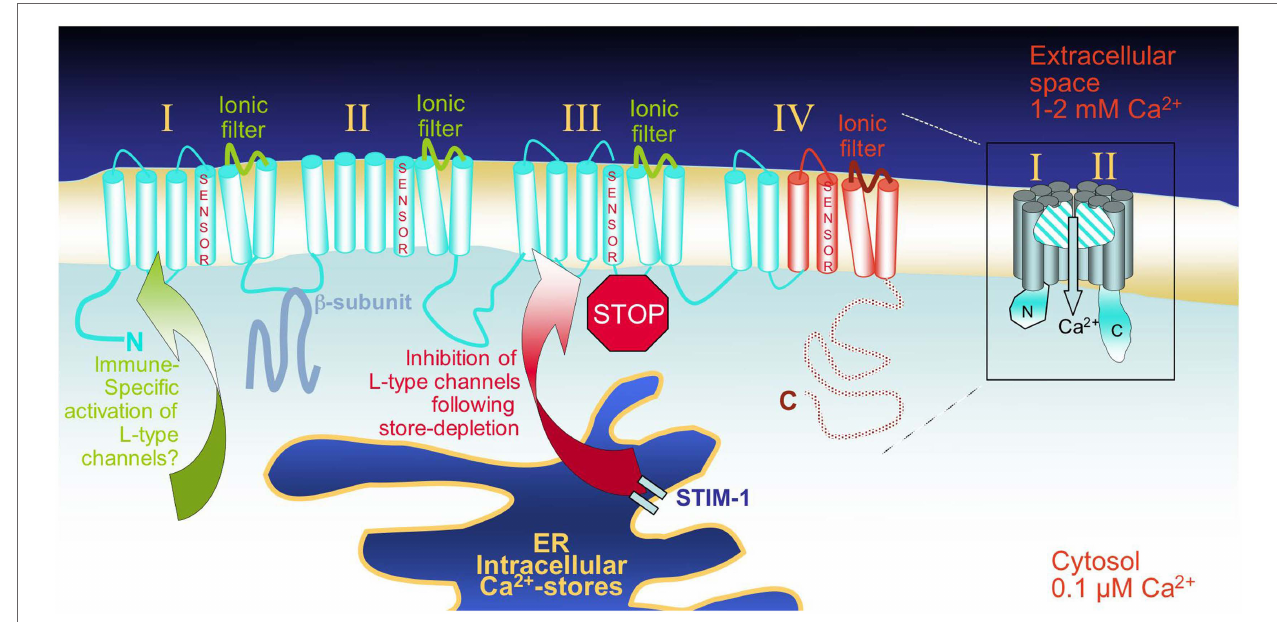
formation of a pore through four groups (I–IV) of six TM domains that line the ionic selectivity filter. The voltage-gated sensor that is essential for gating in excitable cells is located on TM4 of each group. L-type channels are currently discussed as “store-inhibited channels,” representing a novel mechanism of Ca 2 + -signal coordination – upon depletion of the ER Ca 2 + -stores, the ER Ca 2 + -sensing STIM proteins activate store-operated Orai-channels, but at the same time, repress L-type channels. The mode of activation of L-type channel family members in various immune cell types remains to be